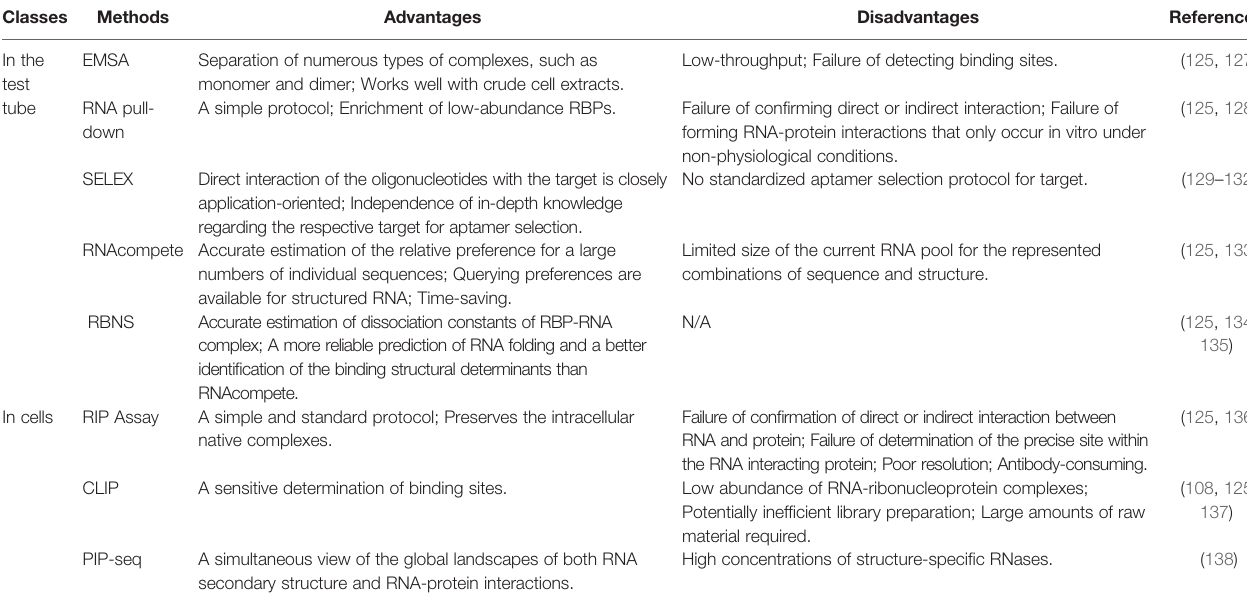
TABLE 3 | Experimental methods for uncovering the interaction between proteins and RNAs.